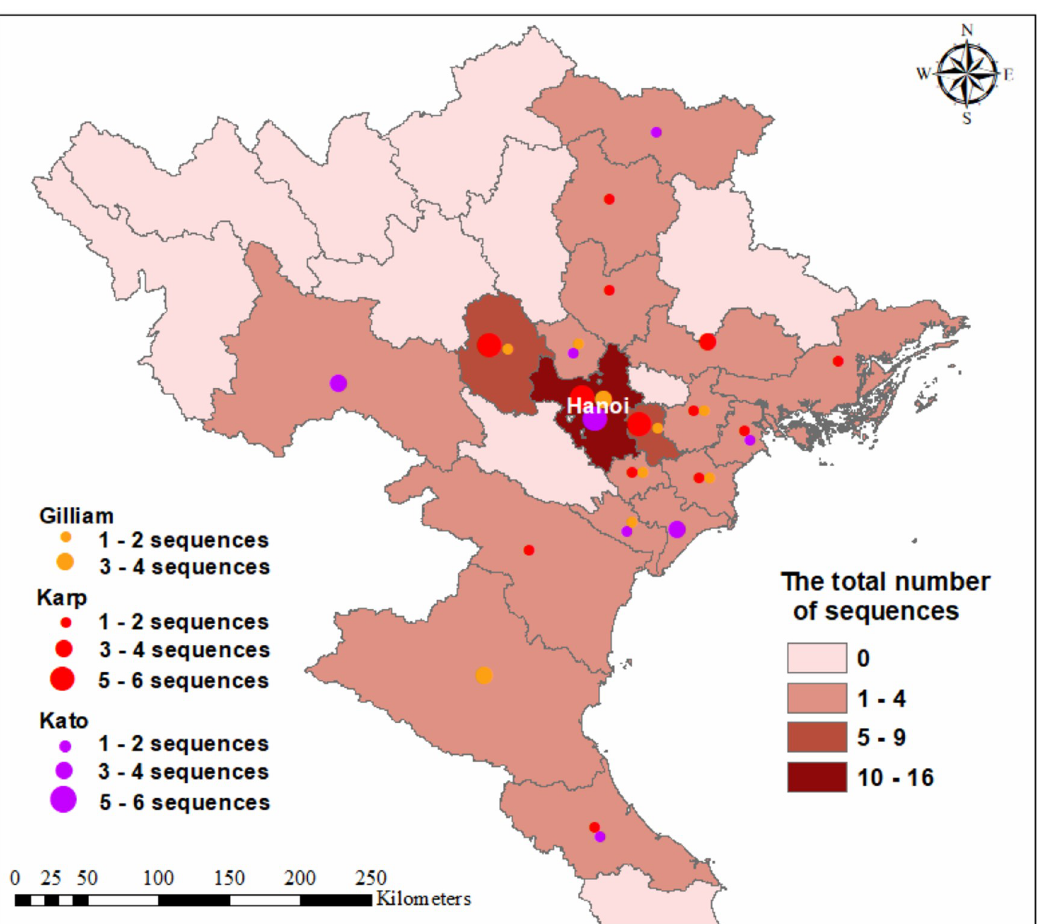
Fig 4. Mapping of Orientia tsutsugamushi genogroups distribution in northern Vietnam. The map was generated using software ArcGIS 10.1 based on the geospatial data from the Center for Spatial Sciences at the University of California, Davis.